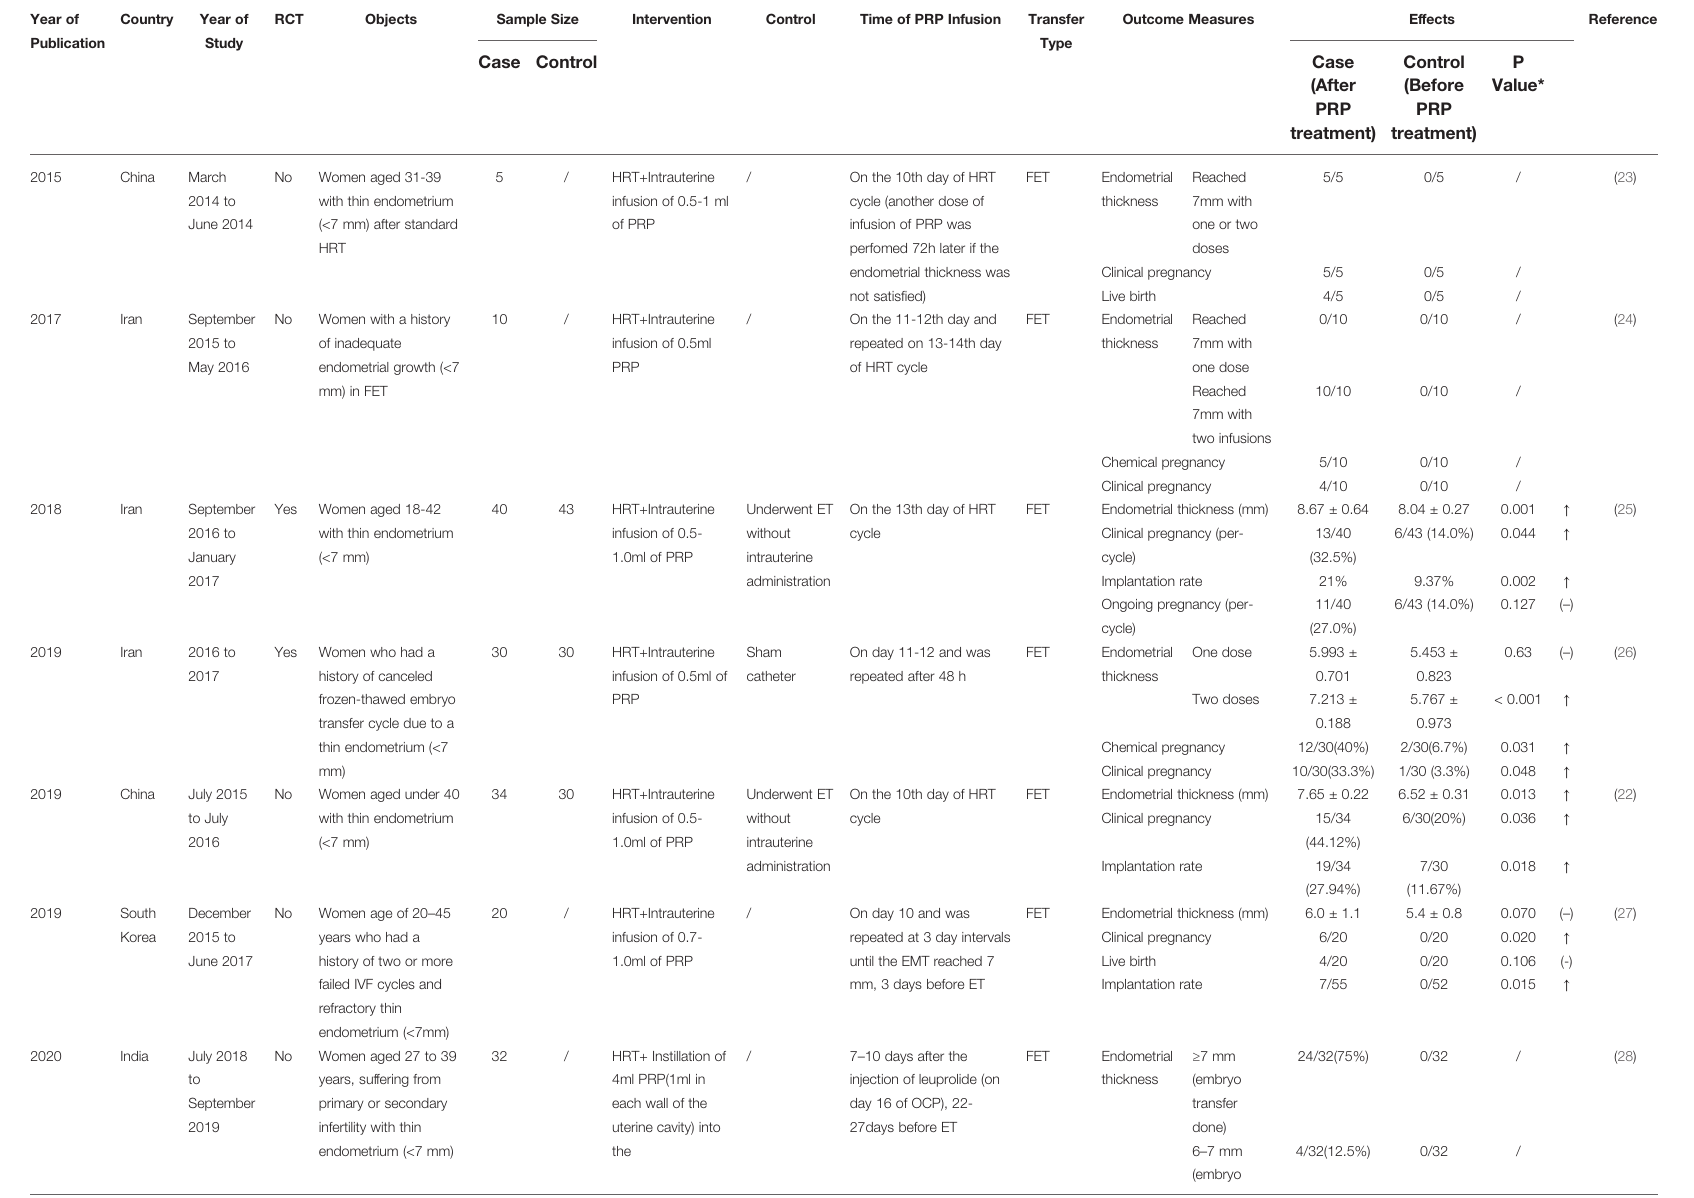
TABLE 1 | Studies assessing the effect of platelet-rich plasma (PRP) treatment in patients with thin endometrium in vitro fertilization. Year of Country Publication